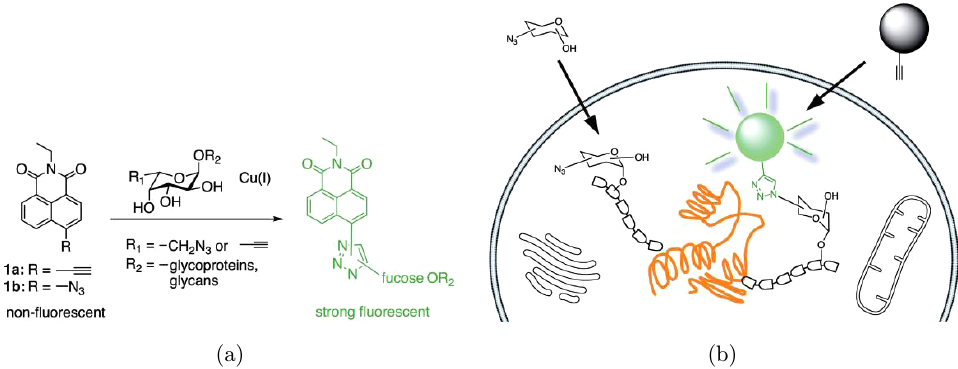
Fig. 6. General bio-orthogonal metabolic labeling strategy for carbohydrates. (a) Probe structures including an azide or alkyne at a position of the ring allows a °uorogenic ligation with 6-modi¯ed fucose analogs. Probes react with the azido alkynyl group of fucosides through Cu(I)-catalyzed [3 þ 2] cycloaddition and generate the °uorescence adduct. (b) Strategy for speci¯c °uorescent labeling of fucosylated glycans in cells. The production of °uorescently labeled glycoproteins bearing modi¯ed fucose (azido fucose shown) is caused by covalently modifying the target glycan with probes 1a or 1b. Adapted with permission from Ref.